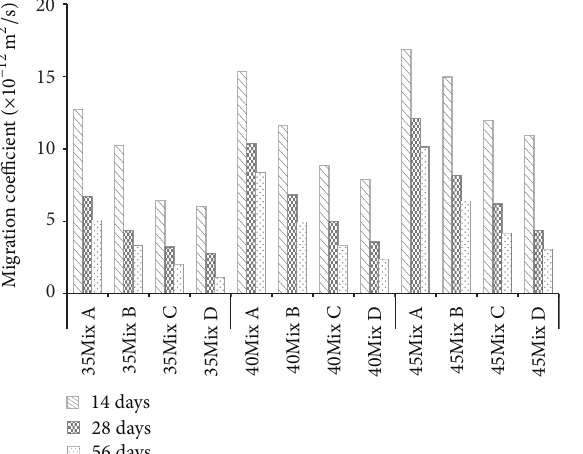
Figure 13: Strength versus chloride migration coefficient of all spec- imens tested at the age of 56